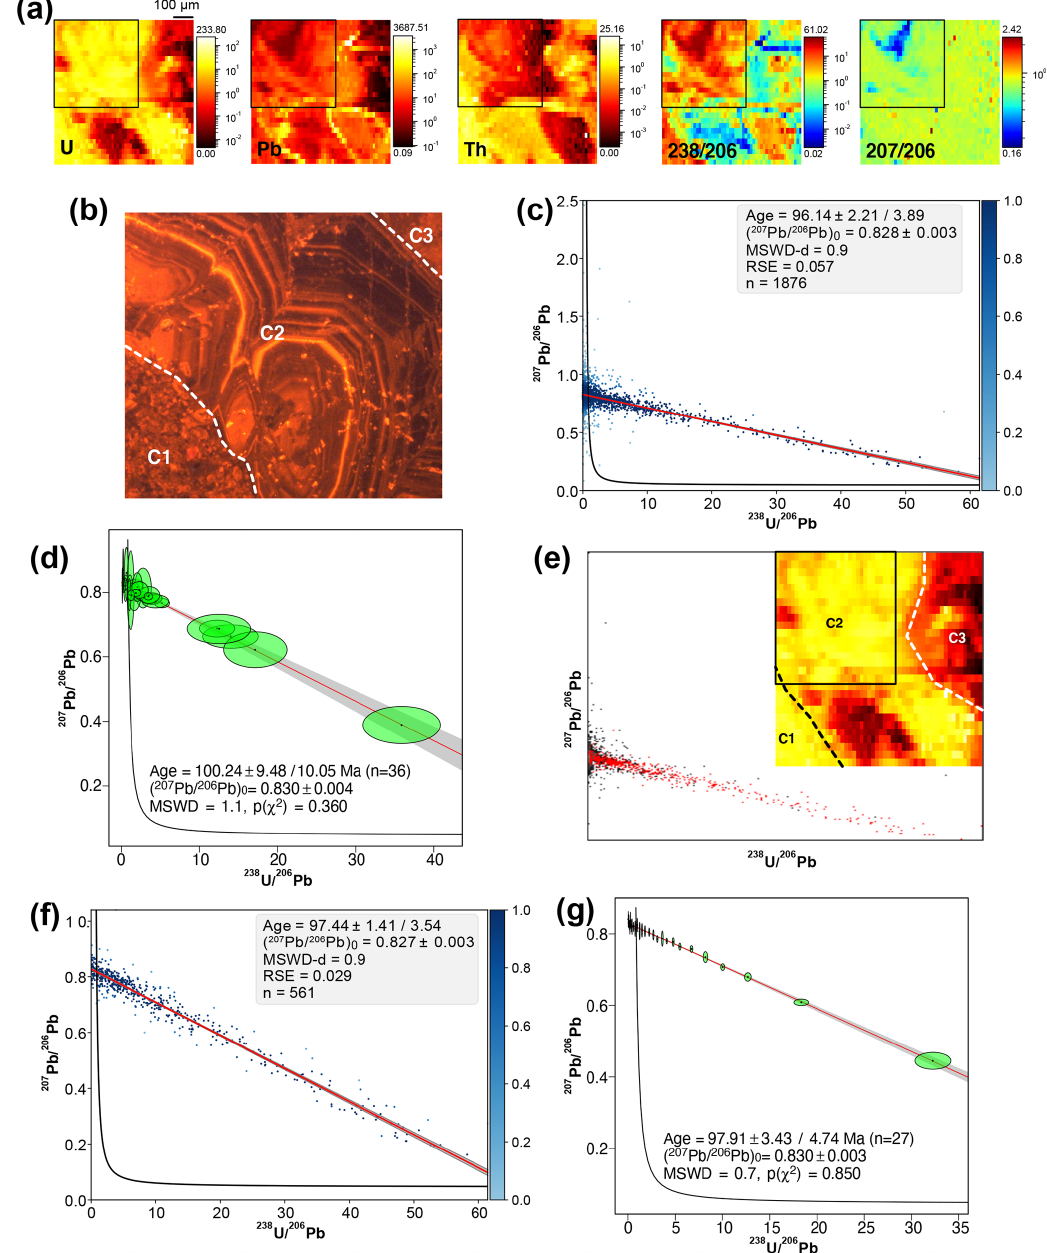
Figure 7. Results obtained for sample ETC2. (a) Semi-quantitative element concentrations in parts per million (U, Pb and Th) and 238 U / 206 Pb– 207 Pb / 206 Pb isotopic maps. Black frames correspond to the image subset selected by co-localisation. (b) Cathodolumines- cence image of an area close to that of the image map. Three distinct cements are distinguished (C1 to C3). (c) TW concordia plot with ages and their uncertainty calculated by robust regression for the entire map. (d) TW concordia plot calculated from discretisation of the entire isotopic map (pseudo-spots). (e) 207 Pb / 206 Pb– 238 U / 206 Pb scatter plot obtained with the ScatterJn plugin from the isotopic maps. Red dots correspond to the pixels of the image subset (black frame in panel a and on the uranium concentration map where the approximate location of distinct cement is given). (f) TW concordia plot with ages and their uncertainty calculated by robust regression for the image subset. (g) TW concordia plot obtained with the approach of Drost et al. (2018) for the entire isotopic map.